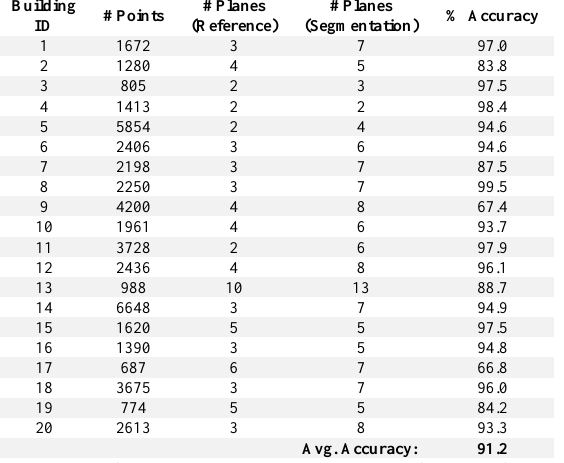
Table 2. Roof plane segmentation accuracies for 20